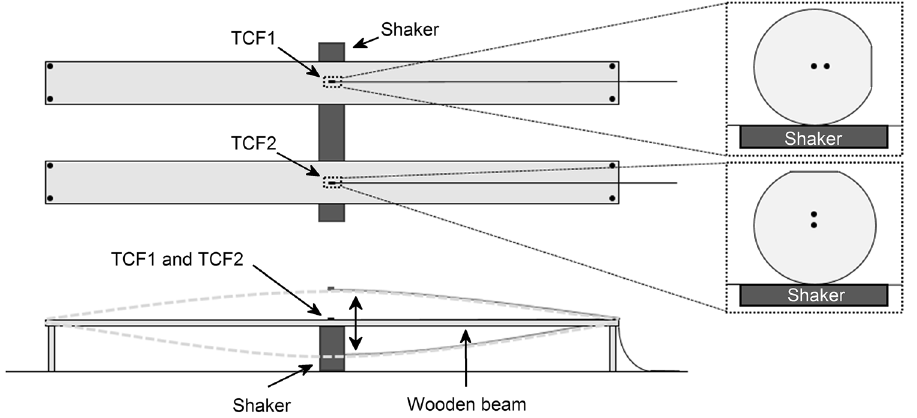
Figure 5. Schematic top and lateral views of the experimental setup. The lateral view shows how the vibration was applied. The close-up shows how the sensor heads were surface bonded to each beam.